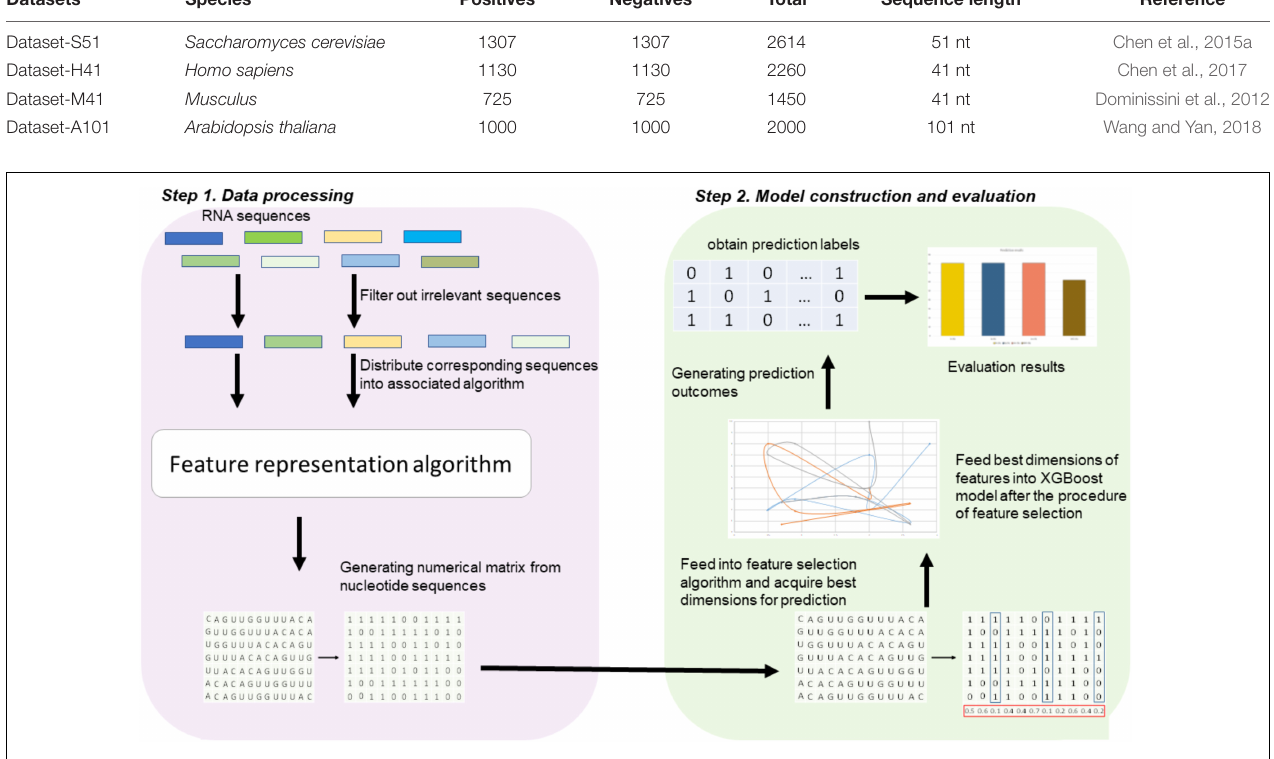
FIGURE 1 | Framework of algorithms proposed in this study. There are two main steps. In the first step, the input RNA sequences are filtered by removing those irrelevant sequences. Then, the remaining sequences are fed into the proposed feature extraction algorithm for feature representation. In the second step, the resulting feature representations are optimized by feature selection, and then, the optimal feature representations are predicted by a XGBoost model.